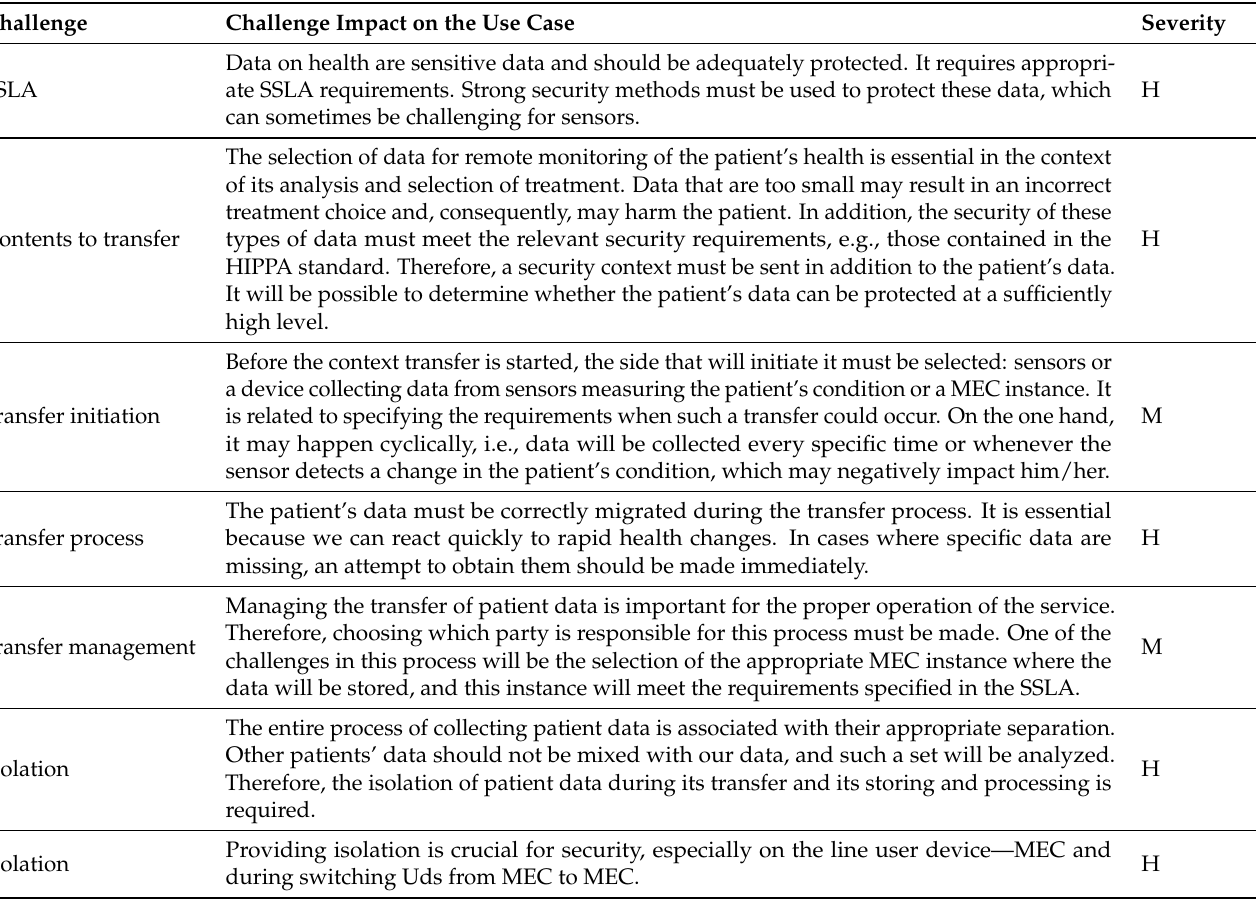
Table 8. Challenges in the remote monitoring of health or wellness data via wireless devices use